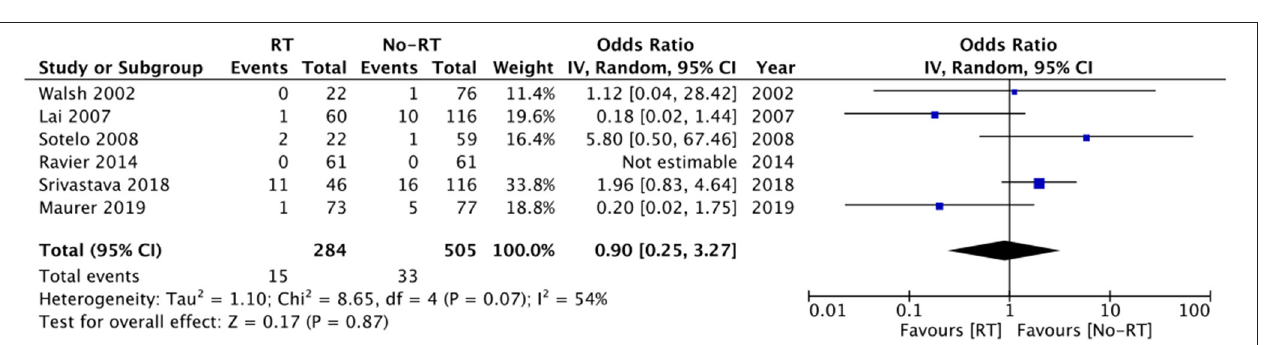
FIGURE 7 | Meta-analysis of urethral atrophy between RT and no-RT groups.